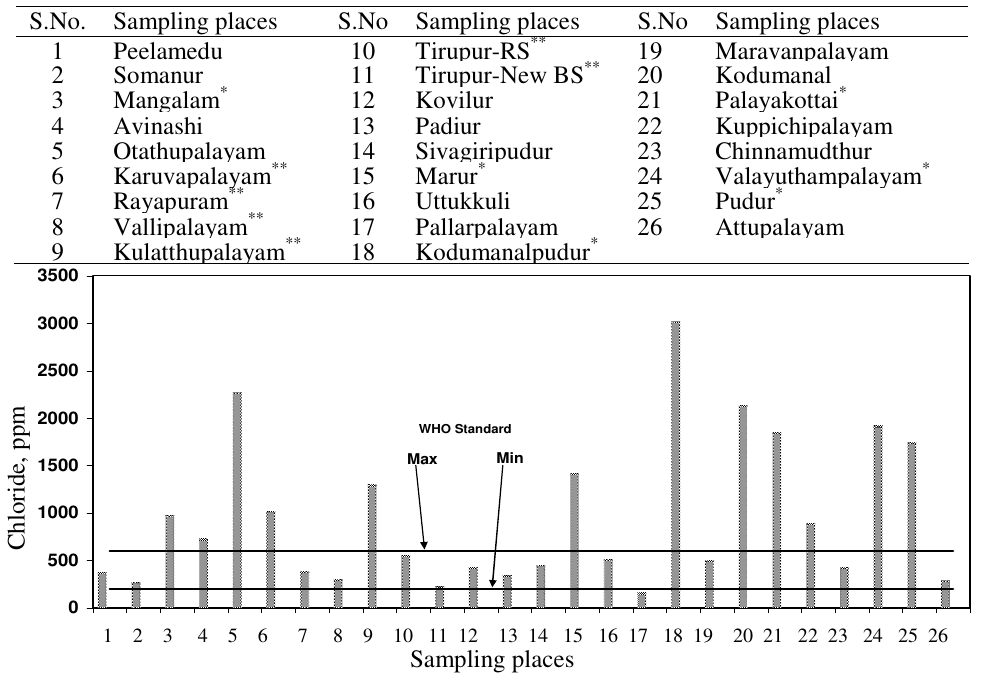
Figure 1. Chloride values of various water samples collected in and around